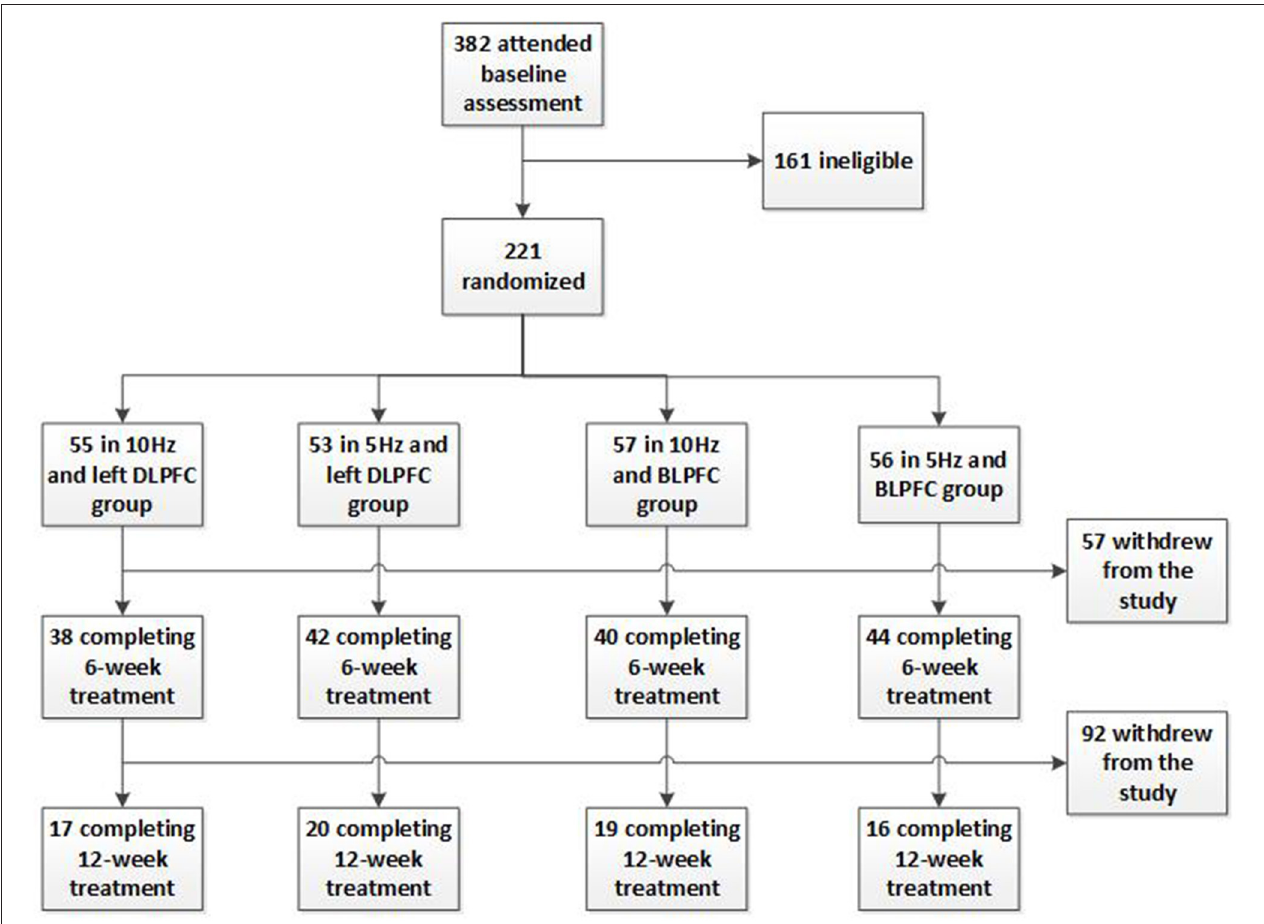
FIGURE 1 | Flowchart of subjects through the